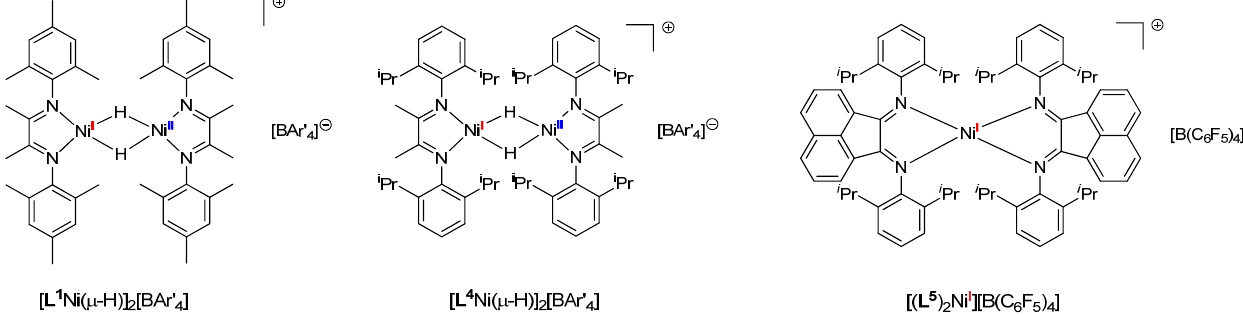
Figure 3. Structures of [ L 1 Ni( μ -H)] 2 [BAr ′ 4 ], [ L 4 Ni( μ -H)] 2 [BAr ′ 4 ], and [( L 5 ) 2 Ni I ][B(C 6 F 5 ) 4 ] (Ar ′ = 3,5-C 6 H 3 (CF 3 ) 2 ).